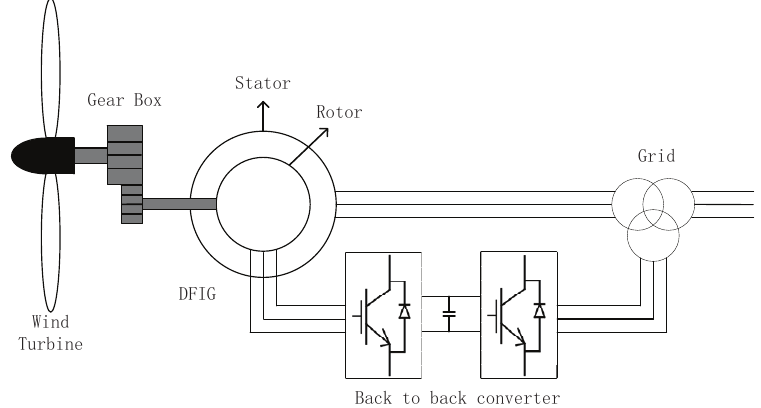
Figure 1. Structure diagram of doubly fed induction